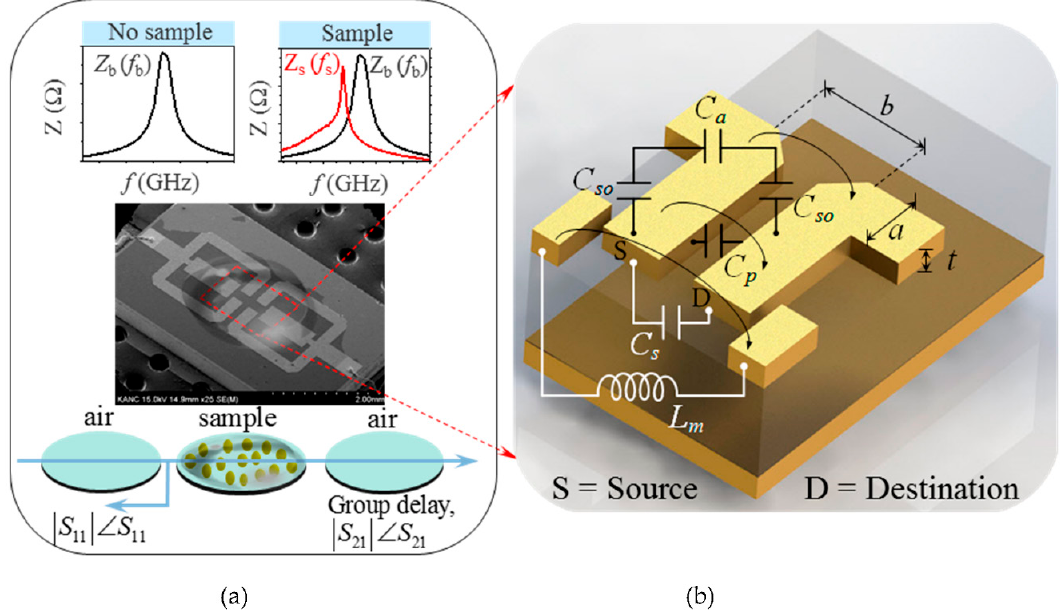
Figure 2. Microwave characterization principle and modeling of sensing region. ( a ) Scanning electron microscope (SEM) image of the fabricated biochip illustrating its sample characterization principle in a microwave regime based on S-parameters, derived parameters, and characteristic impedance self-resonance spectroscopy. ( b ) Equivalent circuit modeling of the sensing region in terms of its sample-dependent coupling capacitance and mutual inductance.